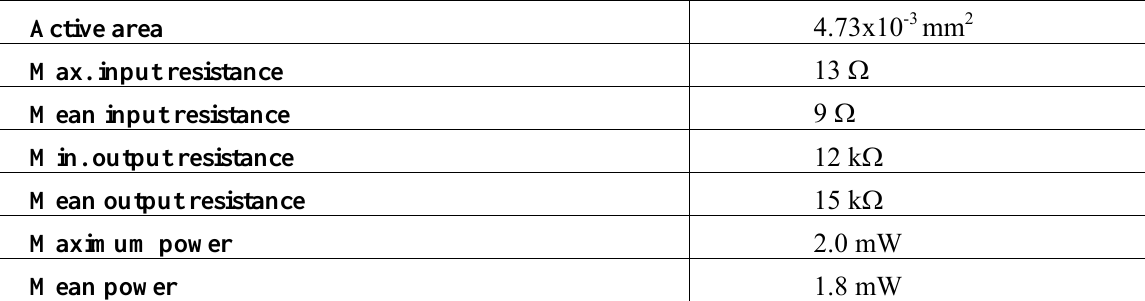
Table 3. Characteristics of the non-linear output